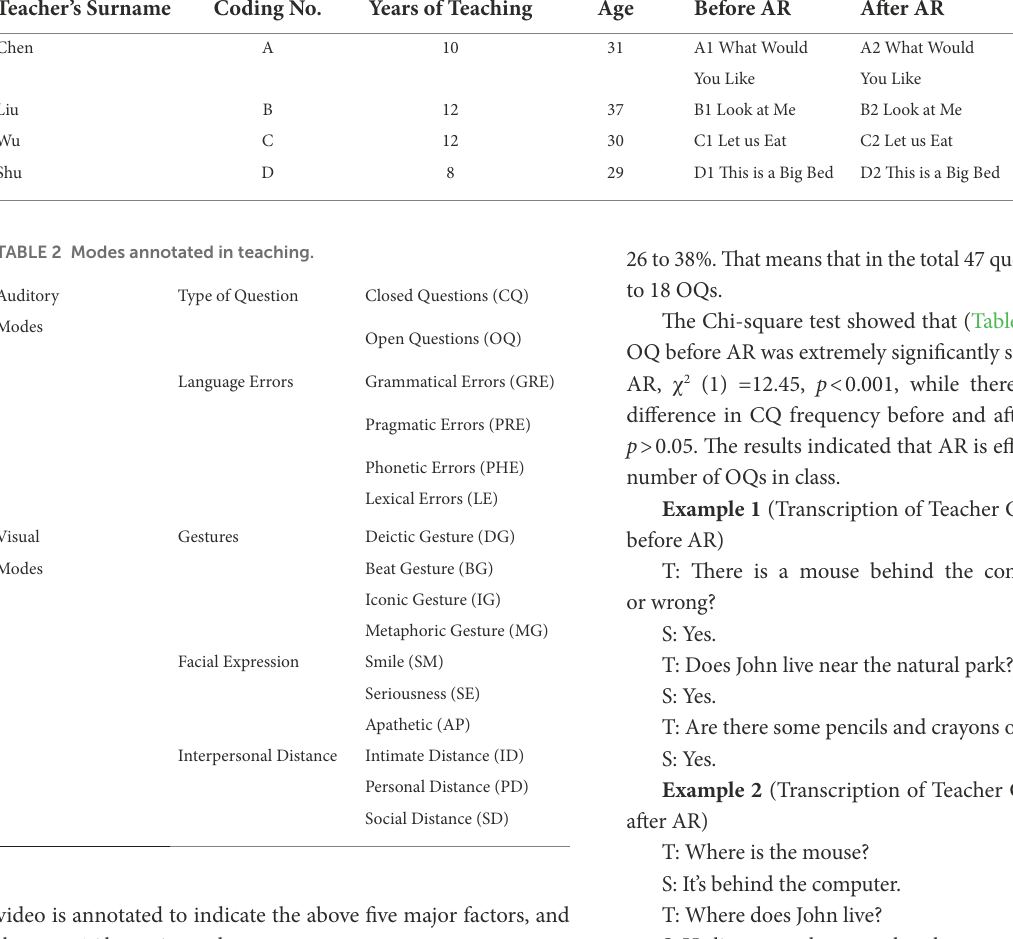
TABLE 1 The teachers’ personal profile and the teaching topics. Teacher’s Surname